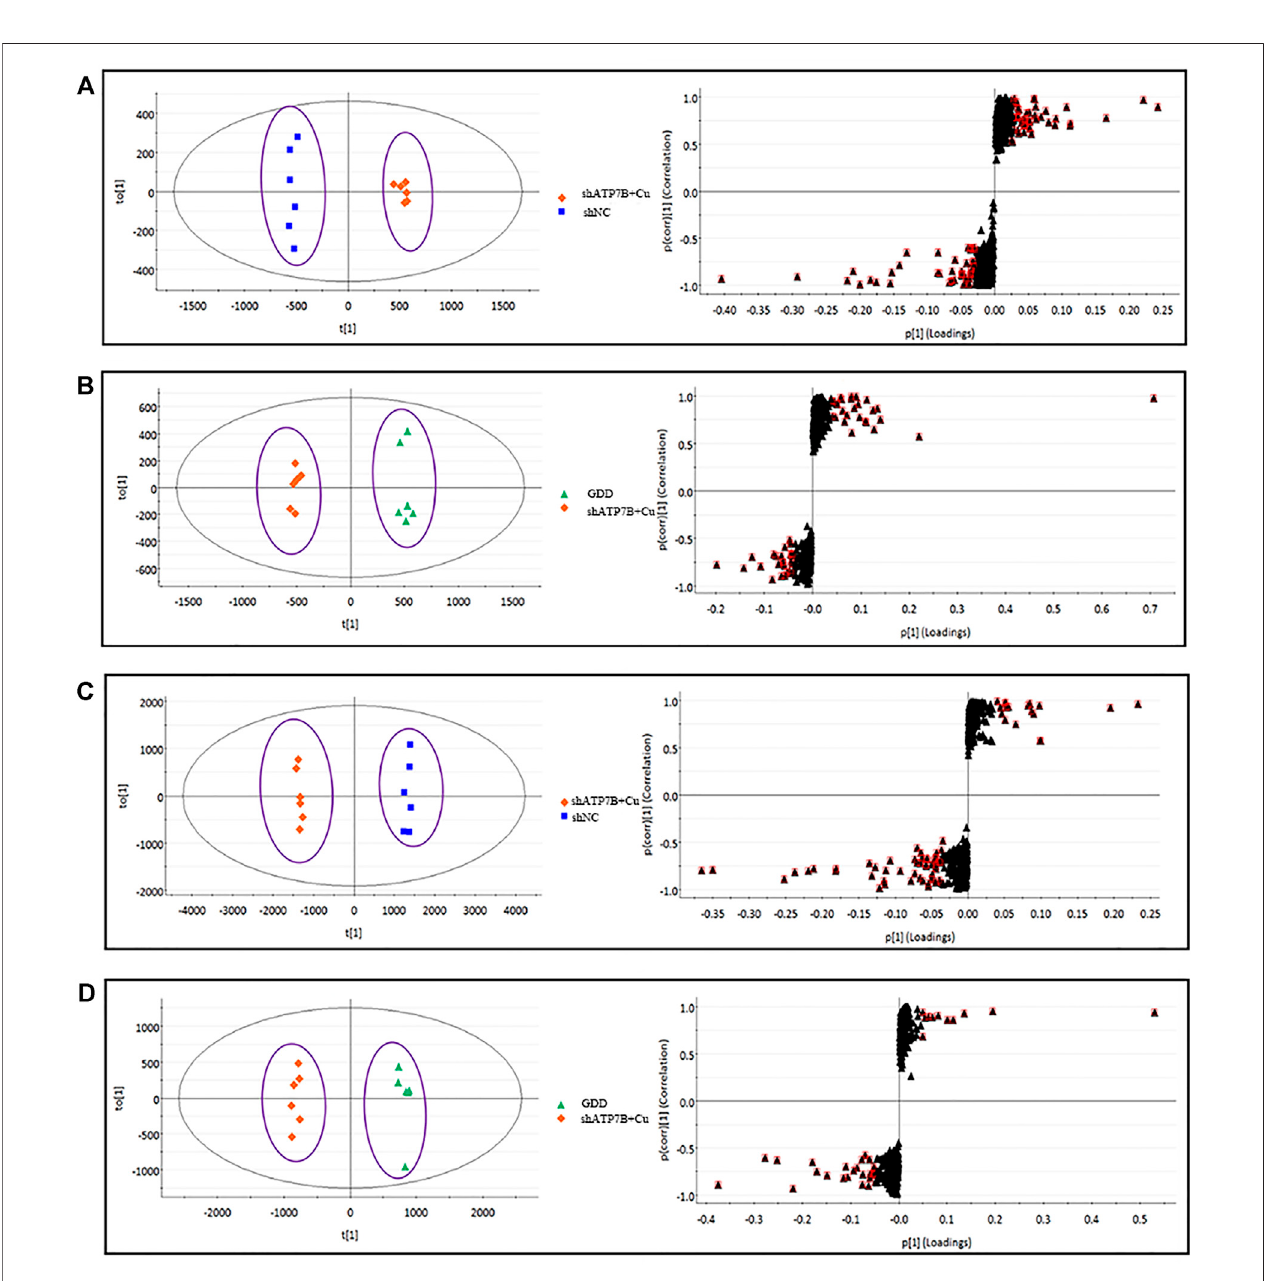
POS- R 2 Y = 99%, Q 2 =